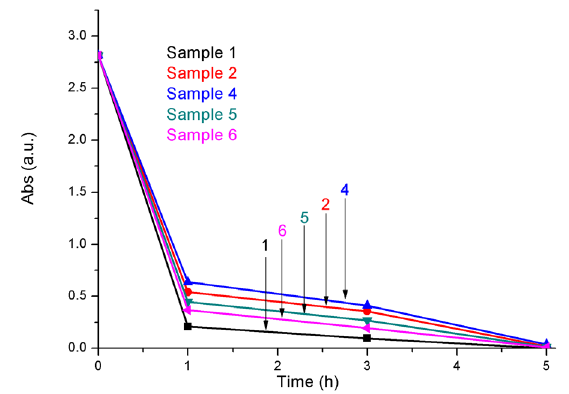
Figure 9. Comparison of photocatalytic activity of samples 1-6.